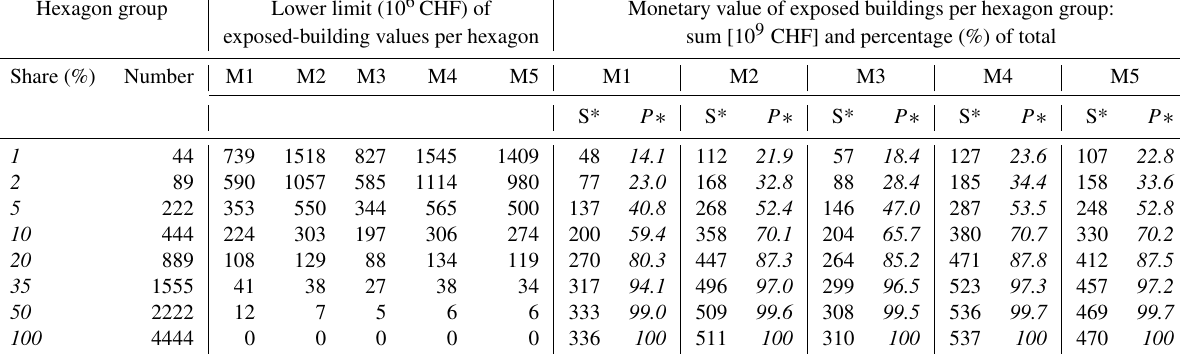
Table 6. Hexagons of 10km 2 grouped in decreasing order of monetary values of flood-exposed buildings in Switzerland. For each group of hexagons and each model (M1 to M5) the following entities are reported: the lower limit of exposed-building values per hexagon (in 10 6 CHF), the sum (S* in 10 9 CHF) of exposed-building values over all hexagons of the respective group, and the percentage ( P ∗ in %) of this sum per group in relation to the total value of flood-exposed buildings in Switzerland. The spatial distribution of six of these groups (highest 2%, lowest 65% and four groups in between) are shown in Fig. 4. Hexagon group Lower limit (10 6 CHF) of Monetary value of exposed buildings per hexagon